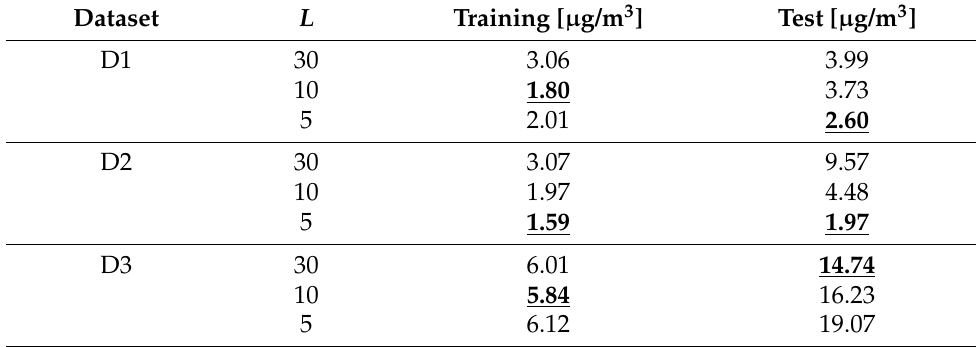
Table 12. E RMS for training and test datasets. Bold underlined values are minimum values.